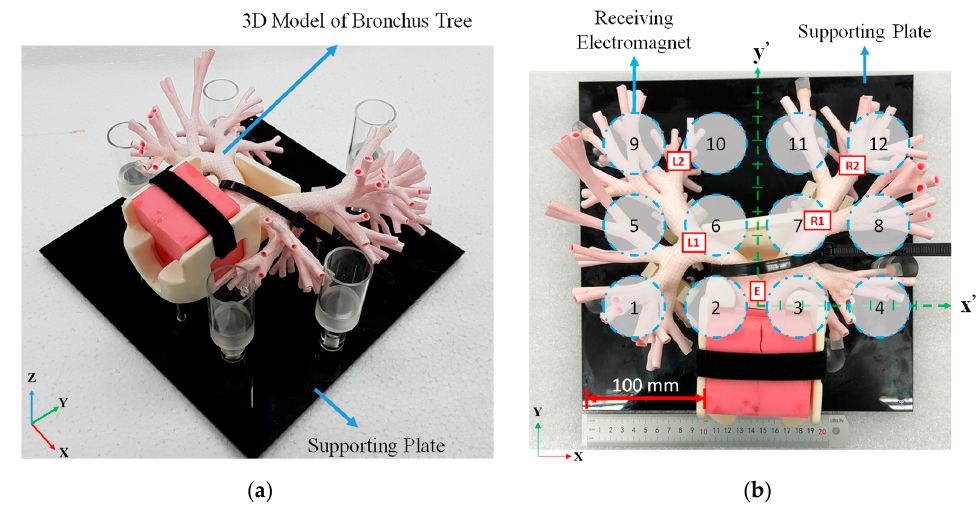
Figure 7. Official/clinical 3D model of bronchus tree for training medical doctors and operators in hospitals: ( a ) isometric view and ( b ) top view showing the relative location between each receiving electromagnet (beneath the model) and each critical entry/intersection location for